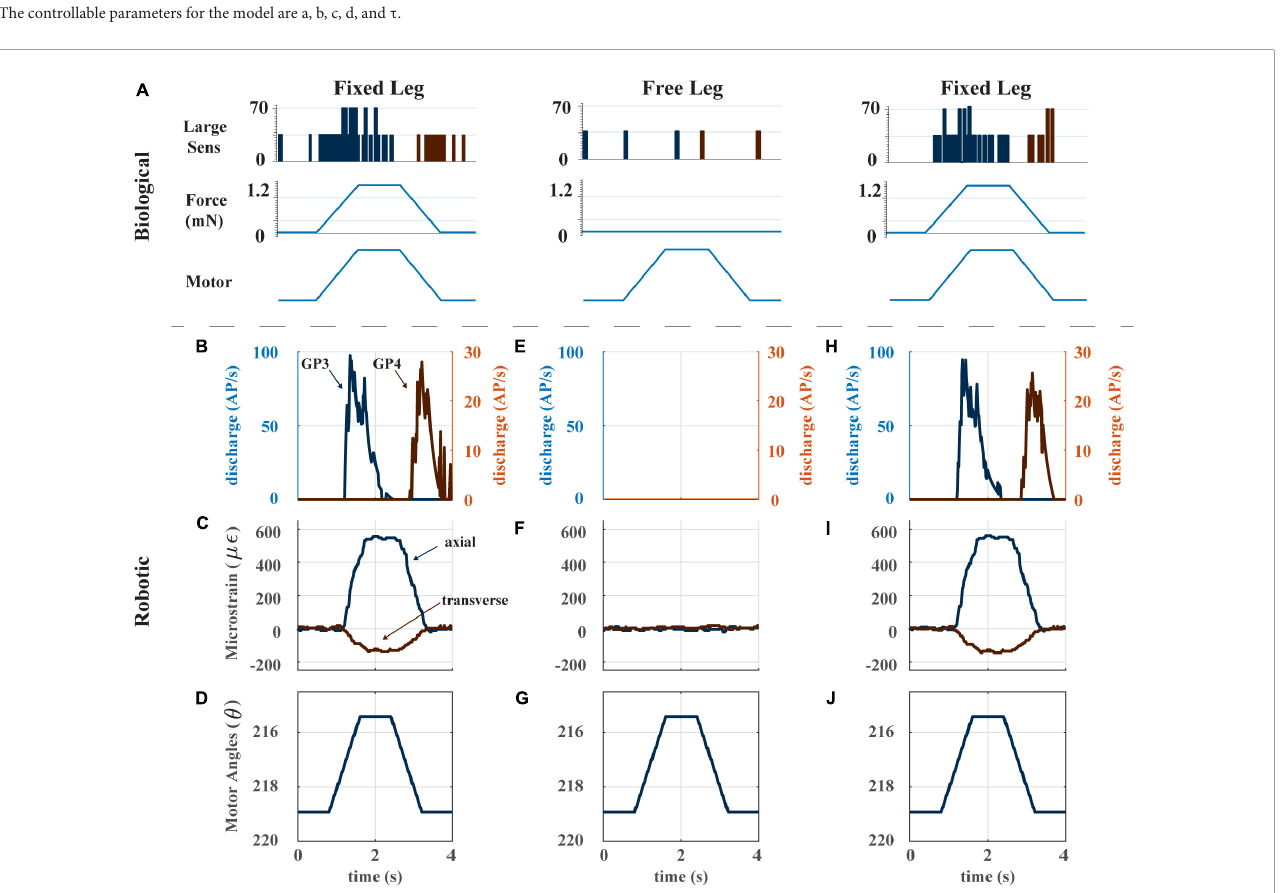
FIGURE4 (A) Biological experiment with ramp and hold stimulus with resulting CS output. Adapted from Figure 6C of Zill et al. (2012). (B) The model CS discharge (group 3 and 4) in response to a single ramp-and-hold-and-release stimulus with distal end of the trochanterofemur fixed. (C) Axial and transverse strain of the trochanterofemur with distal end fixed. (D) Ramp-and-hold-and-release motion commanded to the Dynamixel servomotors. When the distal end of the trochanterofemur is fixed, the servo’s torque generates the bending moment that strains the segment. (E) The model CS discharge (group 3 and 4) in response to a single ramp-and-hold-and-release stimulus with distal end of the trochanterofemur free to move. (F) Axial and transverse strain of the trochanterofemur with distal end free. (G) Ramp-and-hold-and-release motion commanded to the Dynamixel servomotors. (H) The model CS discharge (group 3 and 4) in response to a single ramp-and-hold-and-release stimulus with distal end of the trochanterofemur fixed. (I) Axial and transverse strain of the trochanterofemur with distal end fixed. (J) Ramp-and-hold-and-release motion commanded to the Dynamixel